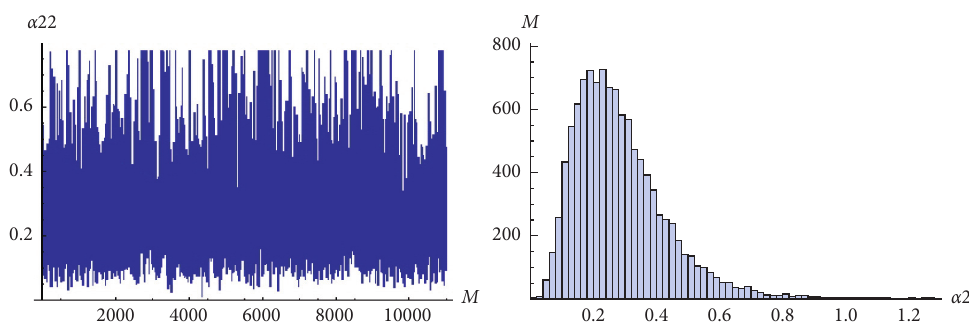
Figure 7: Simulation MCMC generated number/histogram of the parameter β